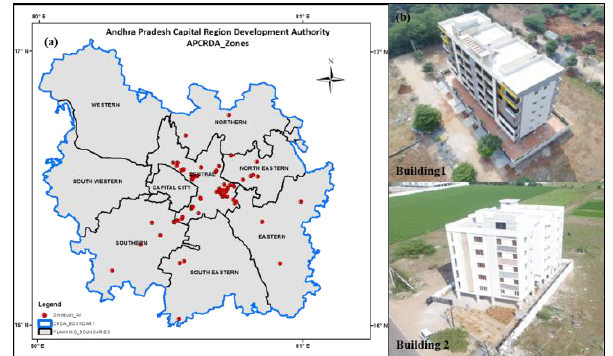
Figure 3: (a) Drone surveyed building locations (b) Buildings selected for the